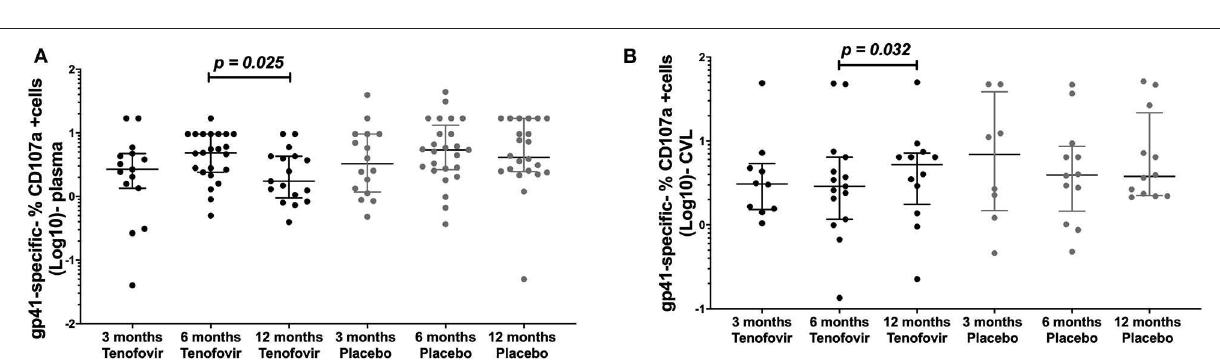
FIGURE 4 | Longitudinal analyses of plasma HIV-specific ADNP [phagoscores (Log10)] in both the tenofovir and the placebo arms. Phagocytic activities [phagoscores (Log10)] to HIV proteins (A) gp120, (B) gp41, (C) p66, and (D) p24. Solid lines indicate the minimum and maximum values of box and whisker plots, with black solid lines across the dots indicate the median at each time point for each study arm. Statistical differences were defined as p < 0.05 and were determined by Wilcoxon signed-rank test. No adjustments were made for multiple comparisons.